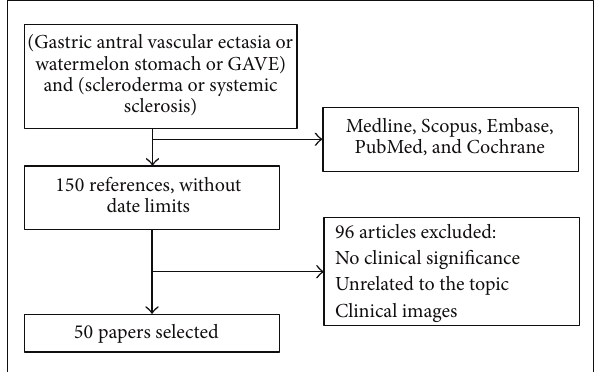
Figure 1: Systemic research and article